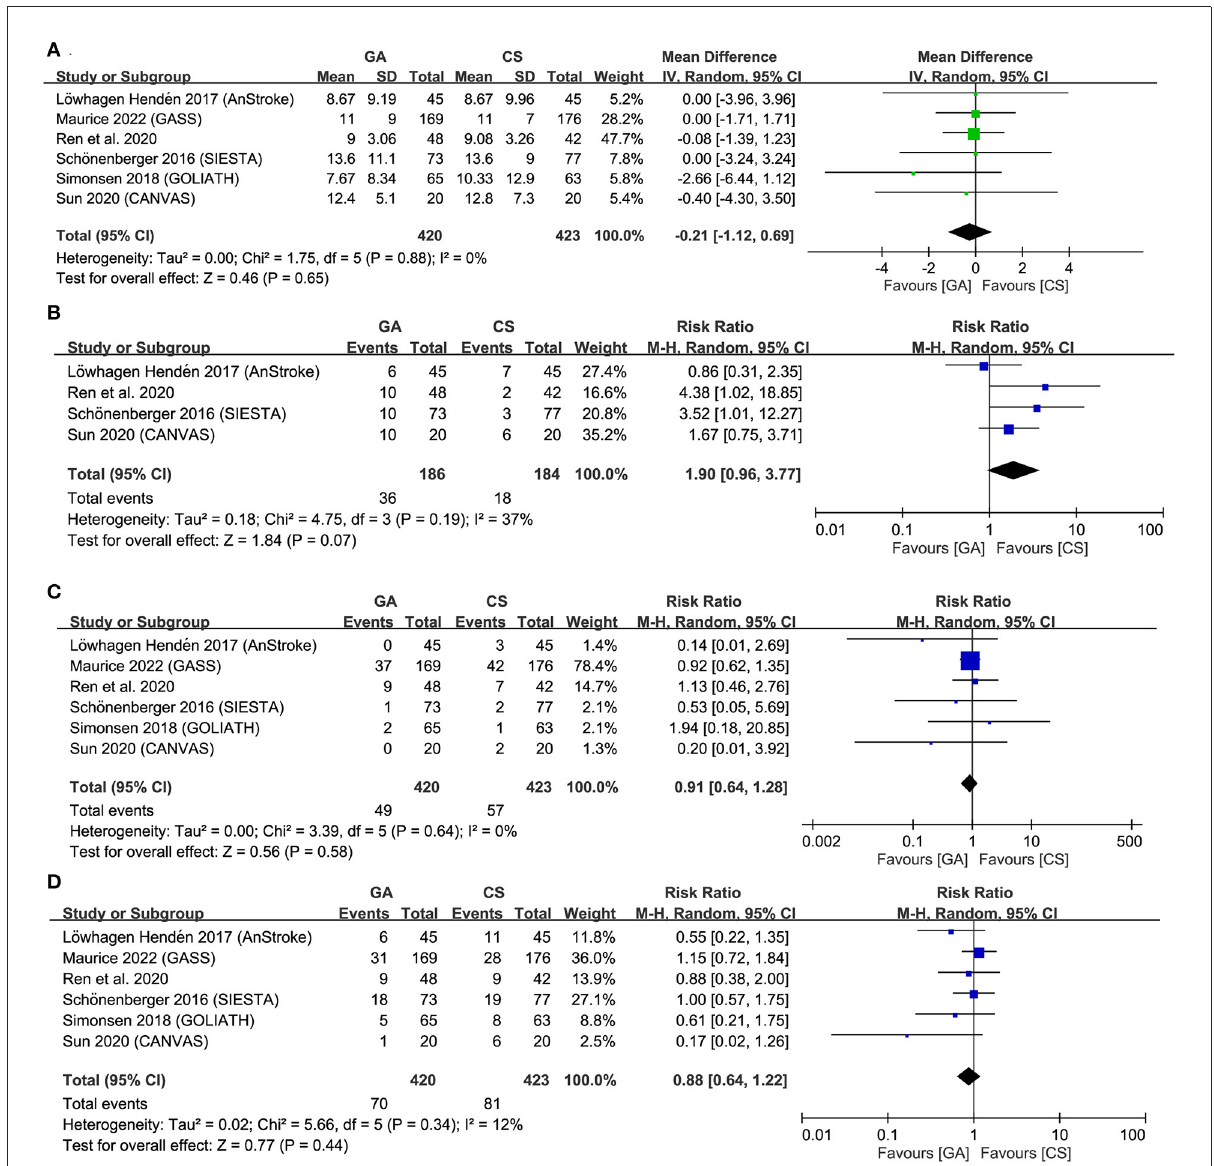
FIGURE5 Forest plot comparing (A) National Institutes of Health Stroke Scale (NIHSS) score at 24–48h, (B) risk of pneumonia, (C) symptomatic intracranial hemorrhage (ICH), and (D) mortality at 3-month follow-up between general anesthesia (GA) and conscious sedation (CS) groups. IV, inverse variance; CI, confidence